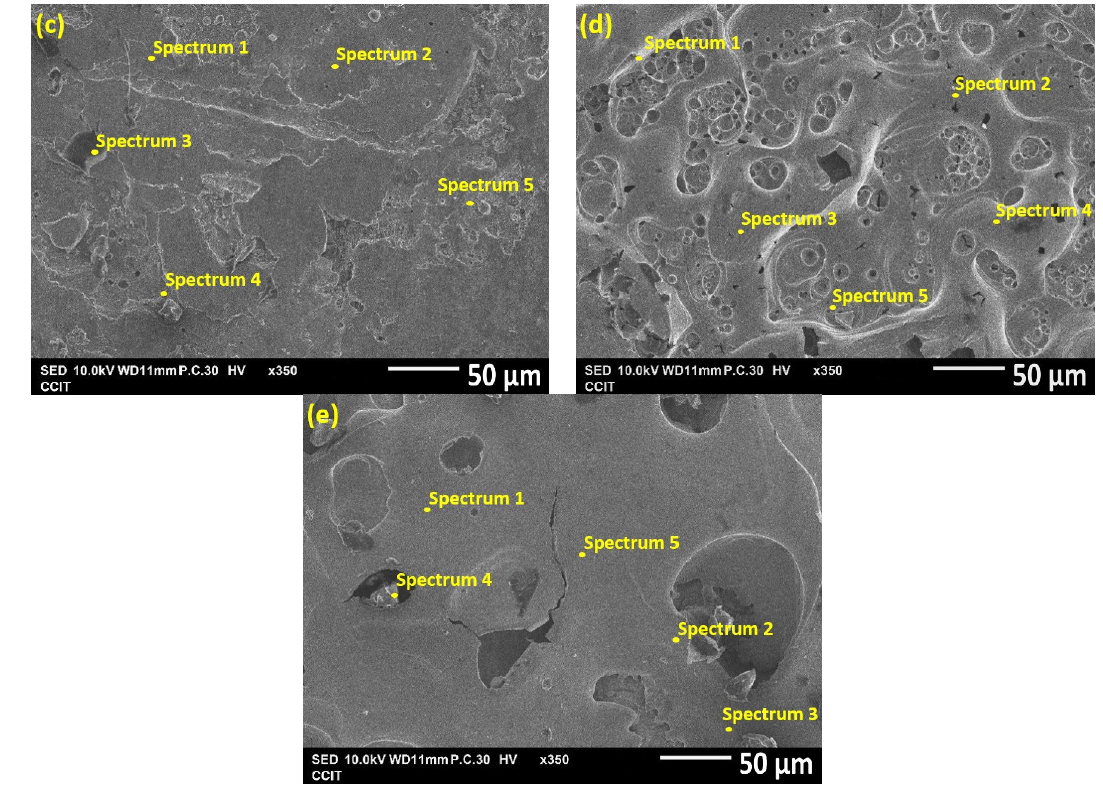
Figure 8. The SEM photographs of various rail types of electric ablation areas after catapult: ( a ) iron rail; ( b ) Ni–P rail; ( c ) annealed Ni–P rail; ( d ) Ni–Mo rail; ( e ) annealed Ni–Mo rail. Table 5. The EDX instrument analysis of all type rails surface after catapult.